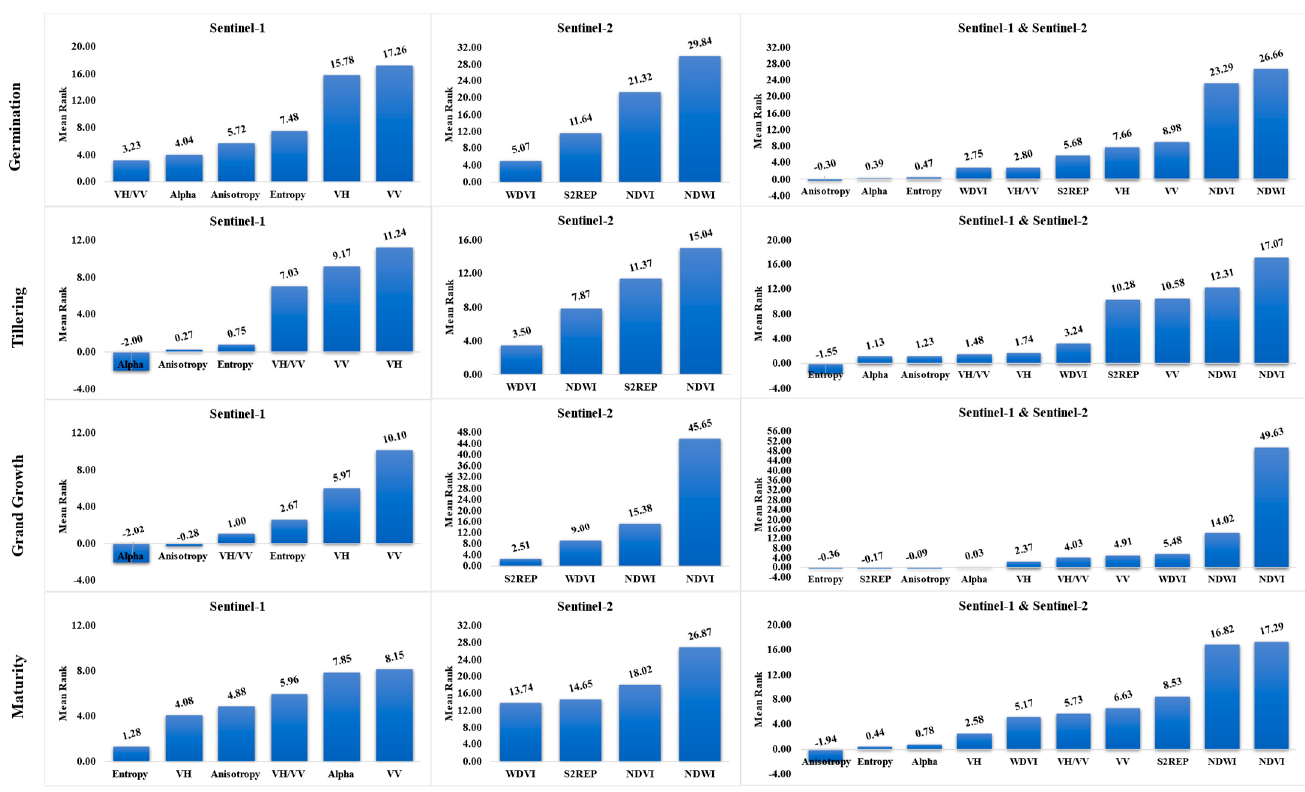
Figure 10. Mean rank of importance of different parameters and indices according to phenology phase.